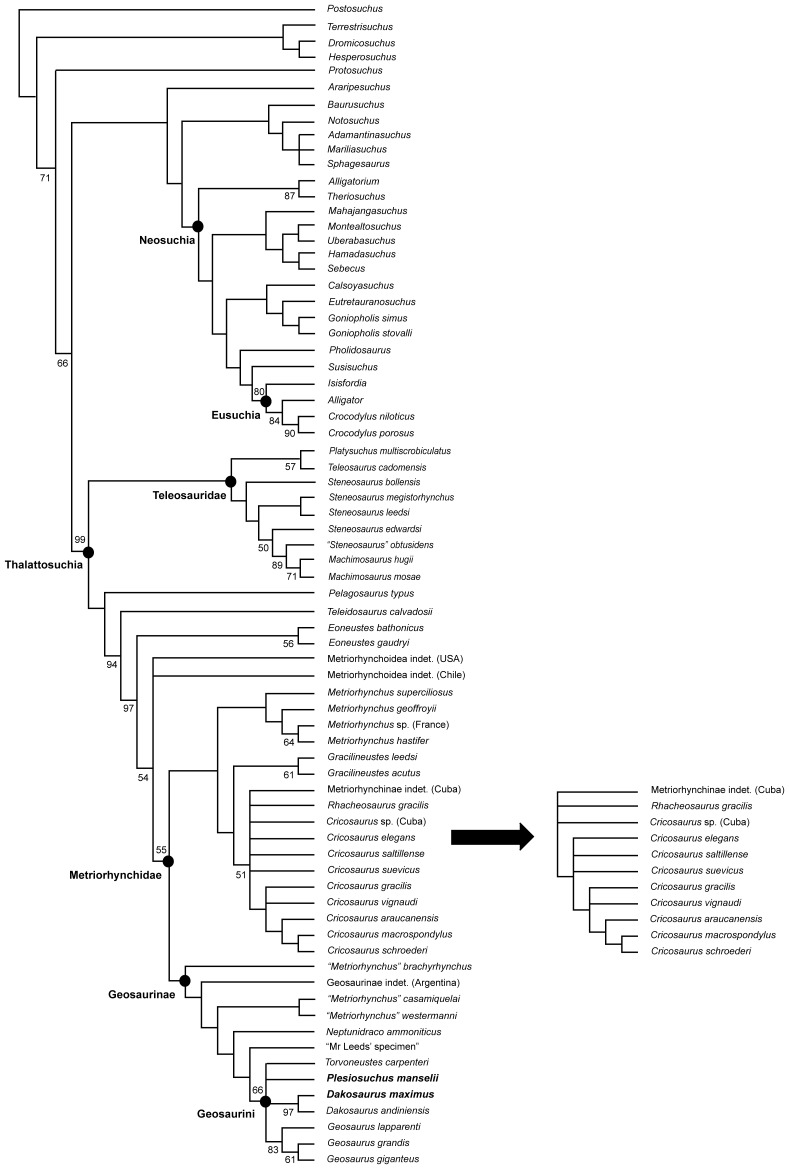
Strict consensus of 22 most parsimonious cladograms, showing the phylogenetic relationships of Plesiosuchus manselii and Dakosaurus maximus within Metriorhynchidae when all characters are unordered.Note that while both are members of the subclade Geosaurini, P. manselii is in an unresolved position with Torvoneustes, Geosaurus and Dakosaurus (D. andiniensis + D. maximus). Length = 627; ensemble consistency index, CI = 0. 506; ensemble retention index, RI = 0. 860; rescaled consistency index, RC = 0. 435. The black arrow points to the only consistent difference in the 50% majority rule consensus topology: the slightly greater resolution in Rhacheosaurini. Bootstrap-values are given above or below the relevant node.